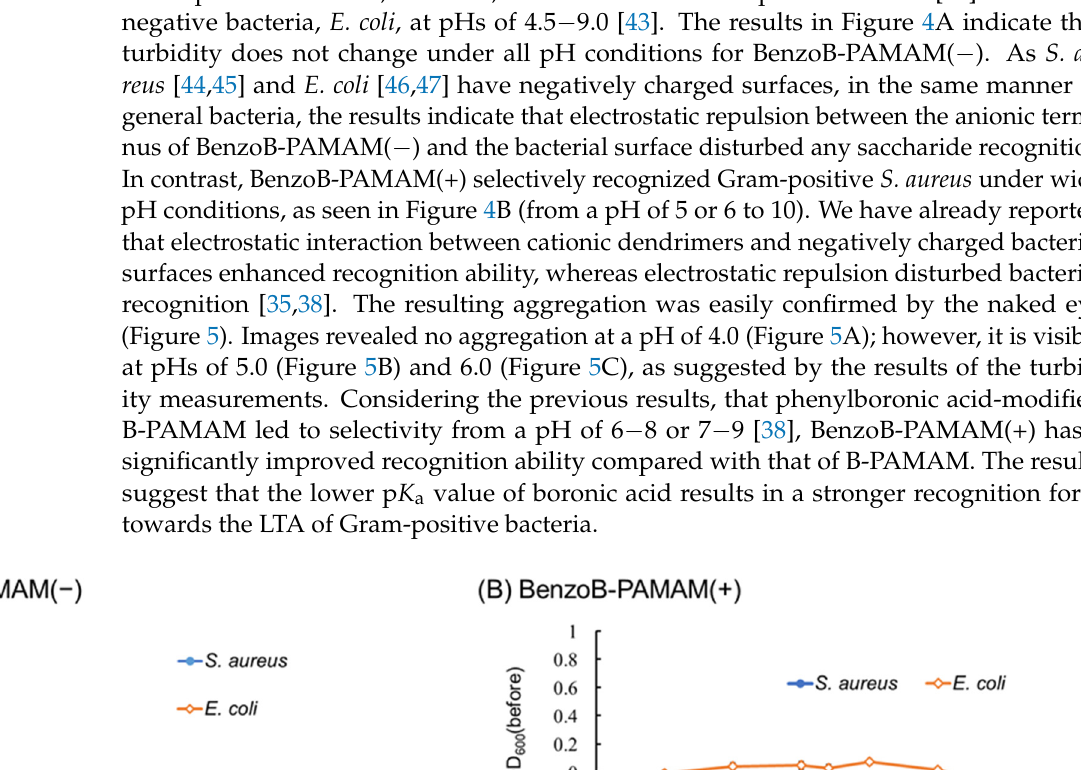
6 of 19 Figure 3. Zeta potential measurement of BenzoB-PAMAMs in PBS ( n = 5). [probe] = 6.6 × 10 − 6 M. Bars express standard deviations (SDs) from five independent experiments. ( A ) BenzoB- PAMAM( − ). ( B ) BenzoB-PAMAM(+). 2.2. Bacterial Recognition by BenzoB-PAMAMs